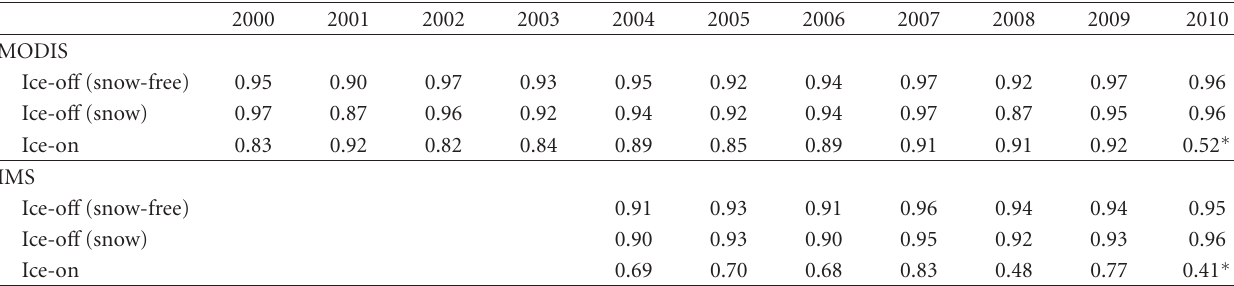
Table 6: Spearman correlation ( R ) values for both mean MODIS- and IMS-detected ice-o ff compared to simulated ice-o ff (both with and without a snow cover on the ice) and ice-on dates. All values are significant at the 0.001